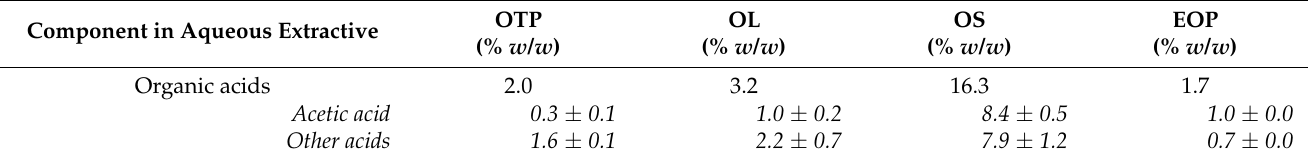
Table 3. Presence of water-extracted organic acids for each olive by-product (% w/w of aqueous extractives). OTP OL OS EOP Component in Aqueous Extractive (% w/w ) (% w/w ) (% w/w ) (% w/w ) Organic acids 2.0 3.2 16.3 1.7 Acetic acid 0.3 ± 0.1 1.0 ± 0.2 8.4 ± 0.5 1.0 ± 0.0 Other acids 1.6 ± 0.1 2.2 ± 0.7 7.9 ± 1.2 0.7 ±